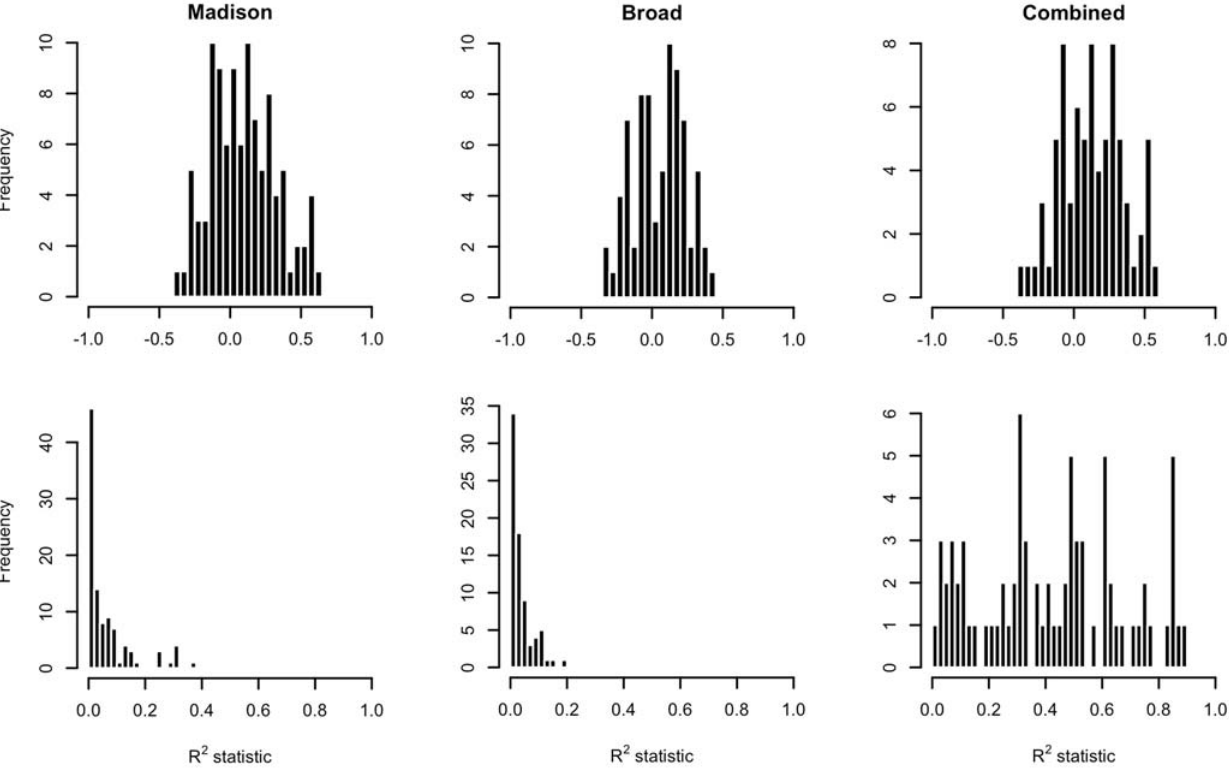
Figure 2. Marginal expression level comparisons of known target pairs. Marginal correlations of m- and miRNA expression levels are typically and inappropriately positive in all datasets under analysis. Further, in the Madison and Broad datasets the amount of variation in targeted mRNA expression captured by that of targeting miRNA is extremely low. In the combined dataset, high R 2 values are indicative only of the amount of variation in mRNA expression due to data origin.